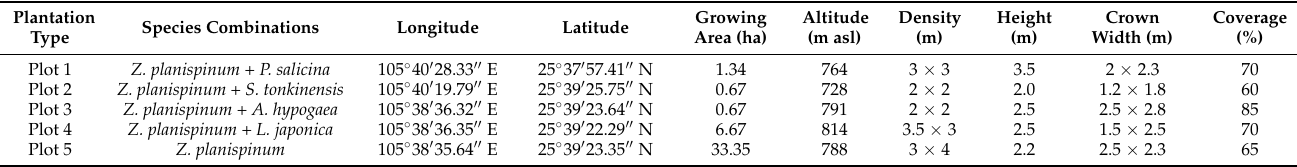
Table 1. General information of